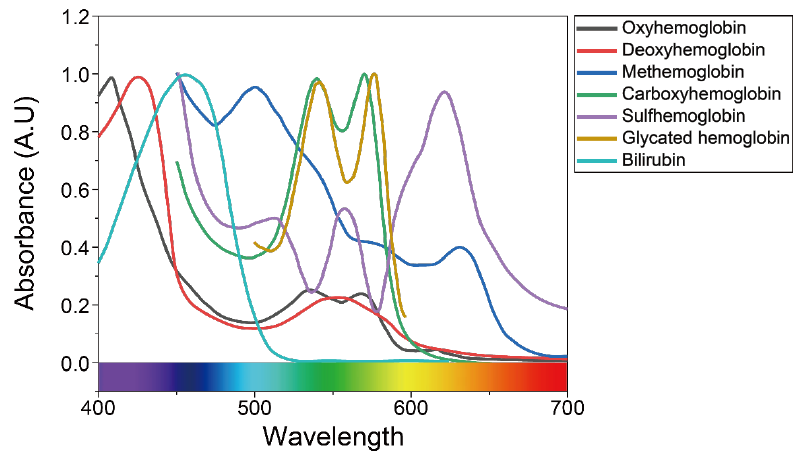
Figure 3. Absorbance of bilirubin and various types of hemoglobin in the visible light region, as mentioned in previous studies. Reproduced with permission from [58–60], ELSEVIER (1981), SPIE (2012), and ACS Publications (2016).